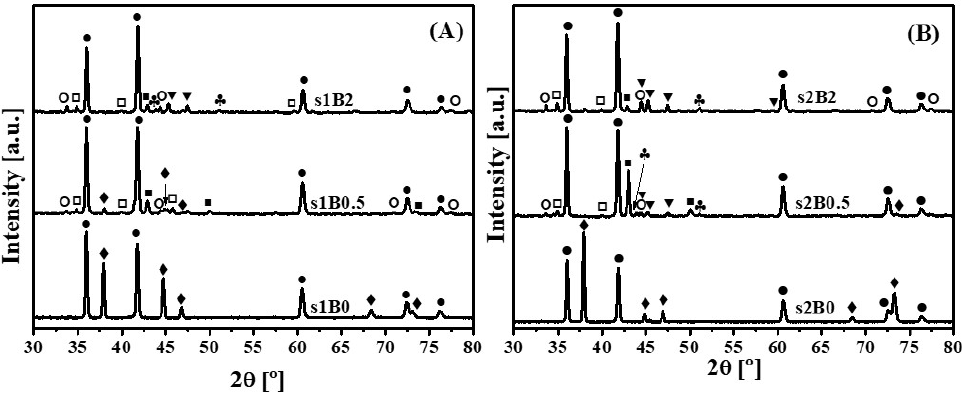
Figure 3. X-Ray Diffraction patterns of the sintered (Ti,Ta)(C,N)-Co-B based cermets. ( A ) First methodology ( s1B0 , s1B0.5 , and s1B2 ), ( B ) second methodology ( s2B0 , s2B0.5 , and s2B2 ), ( (cid:8) ) (Ti,Ta)(C,N) (Fm3m), ( (cid:7) ) (Ti,Ta)Co 2 (Fd3m), ( (cid:72) ) (Ti,Ta)Co 2 (P63 / mmc), ( (cid:4) ) (Ti,Ta)Co 3 (Pm3m), ( ♣ ) α -Co (Fm3m), ( ) (Ti,Ta)B 2 (P6/mmm), and ( ) (Ti,Ta) 3 B 4 (Immm).